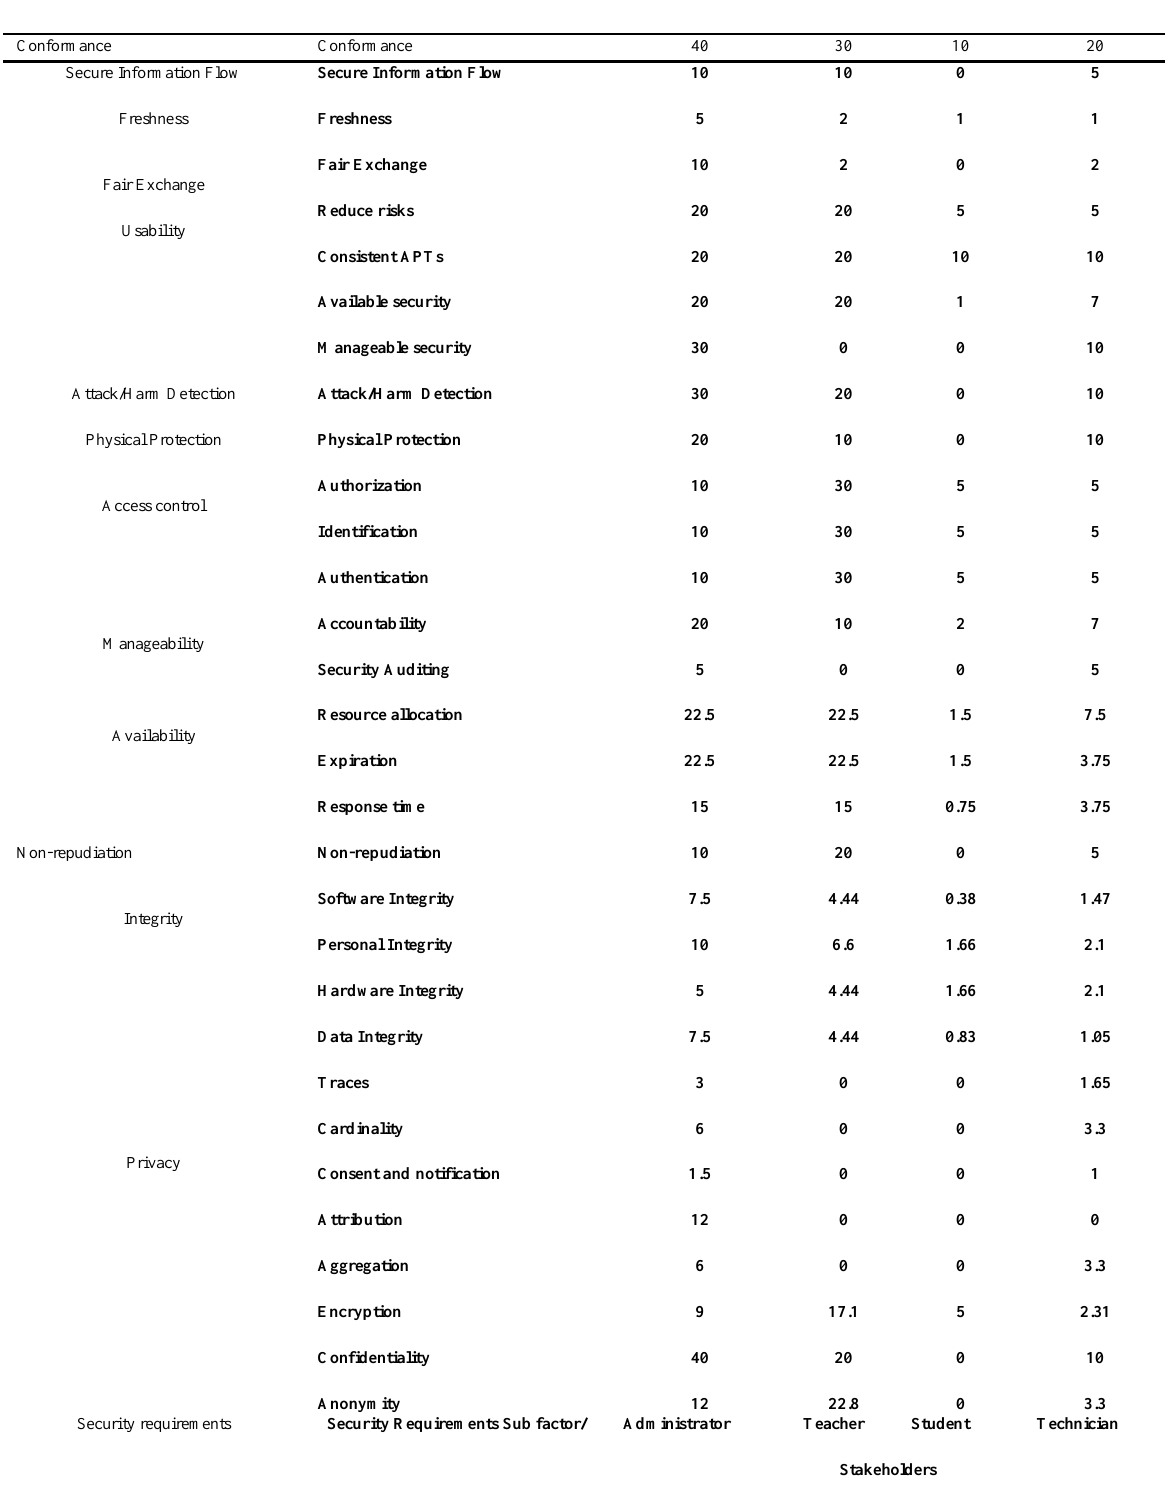
Table 2. The STR Matrix